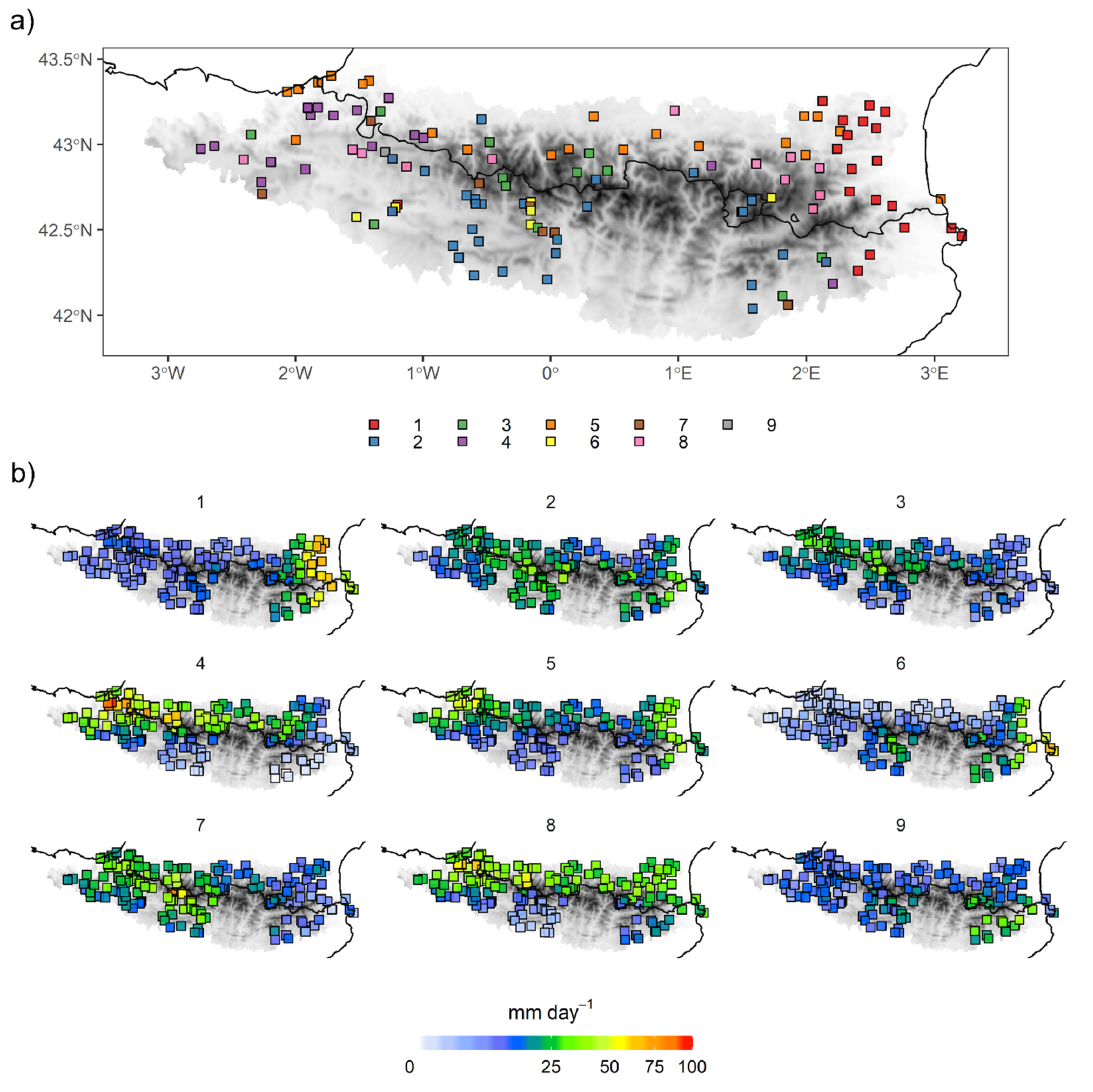
Figure 7. ( a ) Weather type (WT) with the maximum frequency in each rain gauge (each colour represents one of the nine WTs); ( b ) mean daily precipitation for each of the WTs.